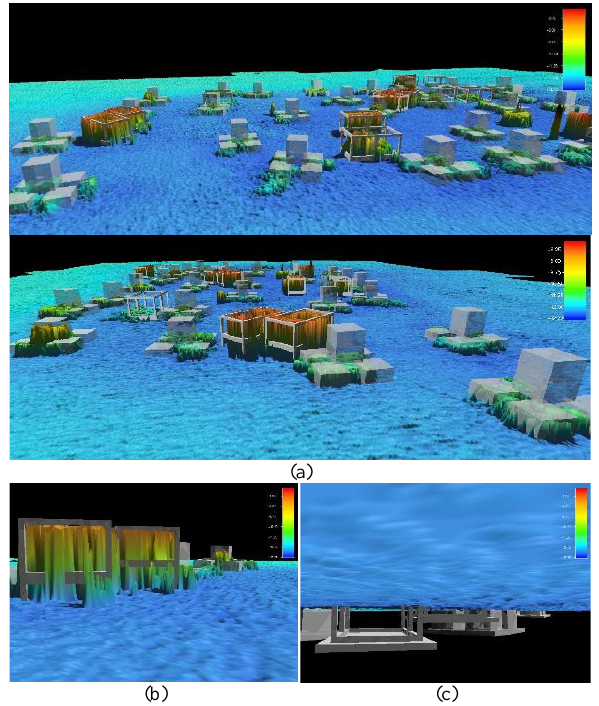
Figure 11. 3D rendering of AR structures and MBES data set 2014 above (a, b) and below the seafloor